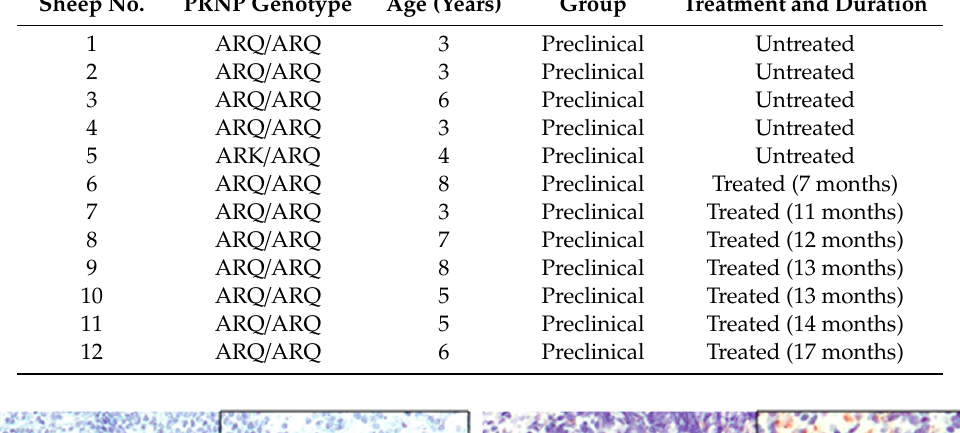
Table 2. Summary of data corresponding to animal samples included in the study. Sheep No.